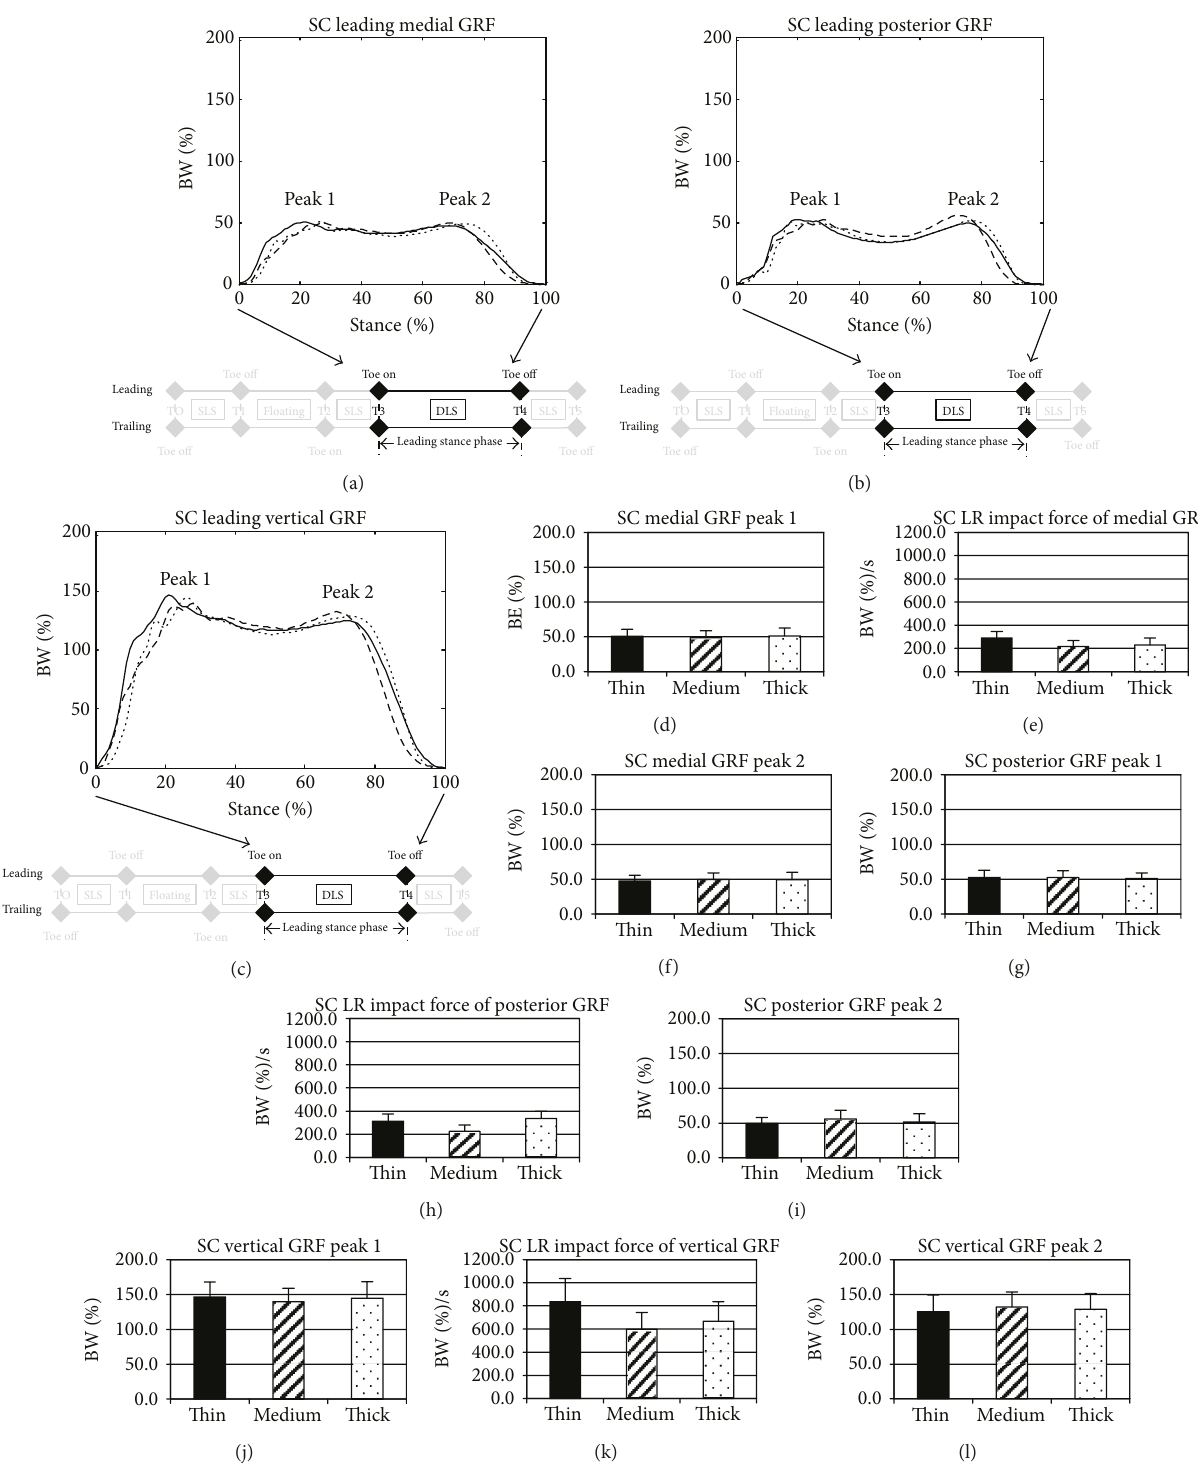
Figure 1: GRF curves on the (a) medial, (b) posterior, and (c) vertical directions of the leading stance limb when performing lateral SC for the thin (thick lines), medium (dash lines), and thick (dot lines) midsole during the stance phase. Peak 1 indicates the peak GRF during the early leading stance, and peak 2 indicates the peak GRF during the late leading stance. Comparisons of these peaks and the loading rate of impact peaks between midsole conditions are displayed as bar charts in (d) – (f) for the medial GRF, (g) – (i) for the posterior GRF, and (j) – (l) for the vertical GRF, with corresponding standard deviations as error bars (black bar: the thin midsole, dashed bar: the medium midsole, and dotted bar: the thick